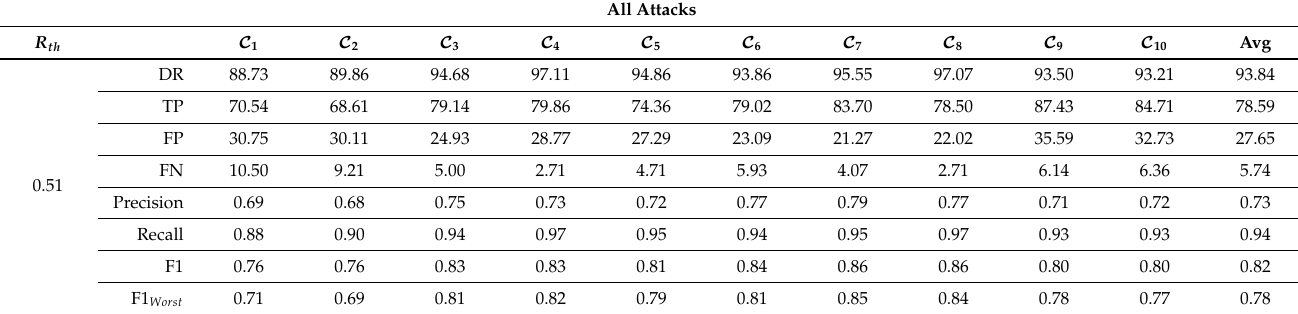
Table 15. Average for all indicators (worst case for F1) per CNN over all